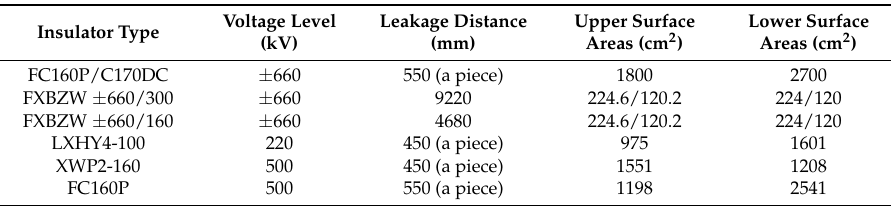
Table 1. Insulator